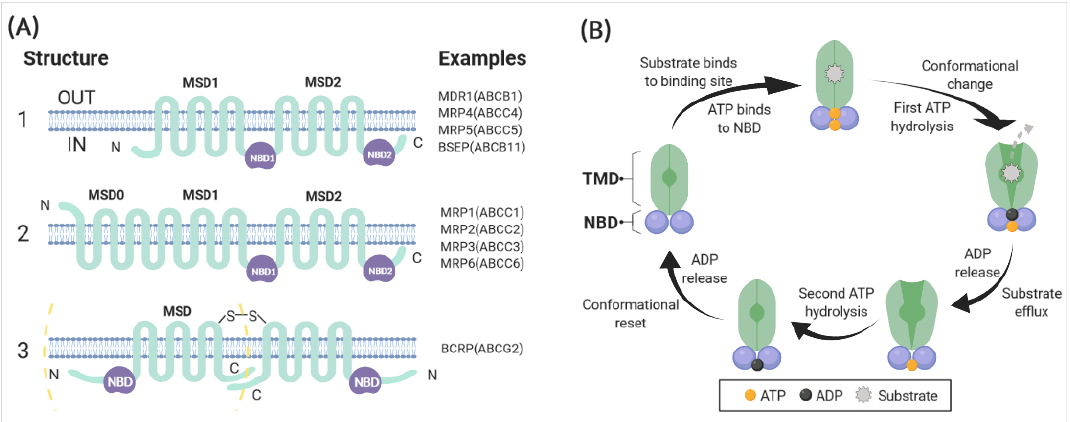
Figure 3. ( A ) Basic structure of ABC transporters. The three different structures of ABC transporters known to render drug resistance. (1) ABC transporters such as ABCB1 and ABCC4 possess 12 transmembrane regions and two ATP-binding sites. (2) ABCC1, 2, 3 and 6 are similar in structures in that they have two ATP-binding regions. Compared with ABCB1, they have an amino-terminal end extension that contains five transmembrane regions, with a total of 17 transmembrane regions. (3) ABCG2 “half-transporter” and ABCG2 homodimer. The “half-transporter” ABCG2 just contains six transmembrane regions and one ATP-binding site. This kind of transporter is thought to function as either a homodimer or an oligomer (Chen, Manautou [38]). ( B ) Schematic representation of the proposed pumping action of ABCB1. The substrate of ABCB1 binds to the binding pocket in the transmembrane domains (TMDs), and ATP binds to the two ATP-binding sites in the nucleotide-binding domains (NBDs). Then, the first ATP hydrolysis provides energy for the generation of a conformational change from which the substrate is released. This is followed by the hydrolysis of the second ATP, which resets the altered conformation, allowing repeating of the efflux process (Robey, Pluchino [16]). Figures were created with BioRender.com (accessed on 22 March